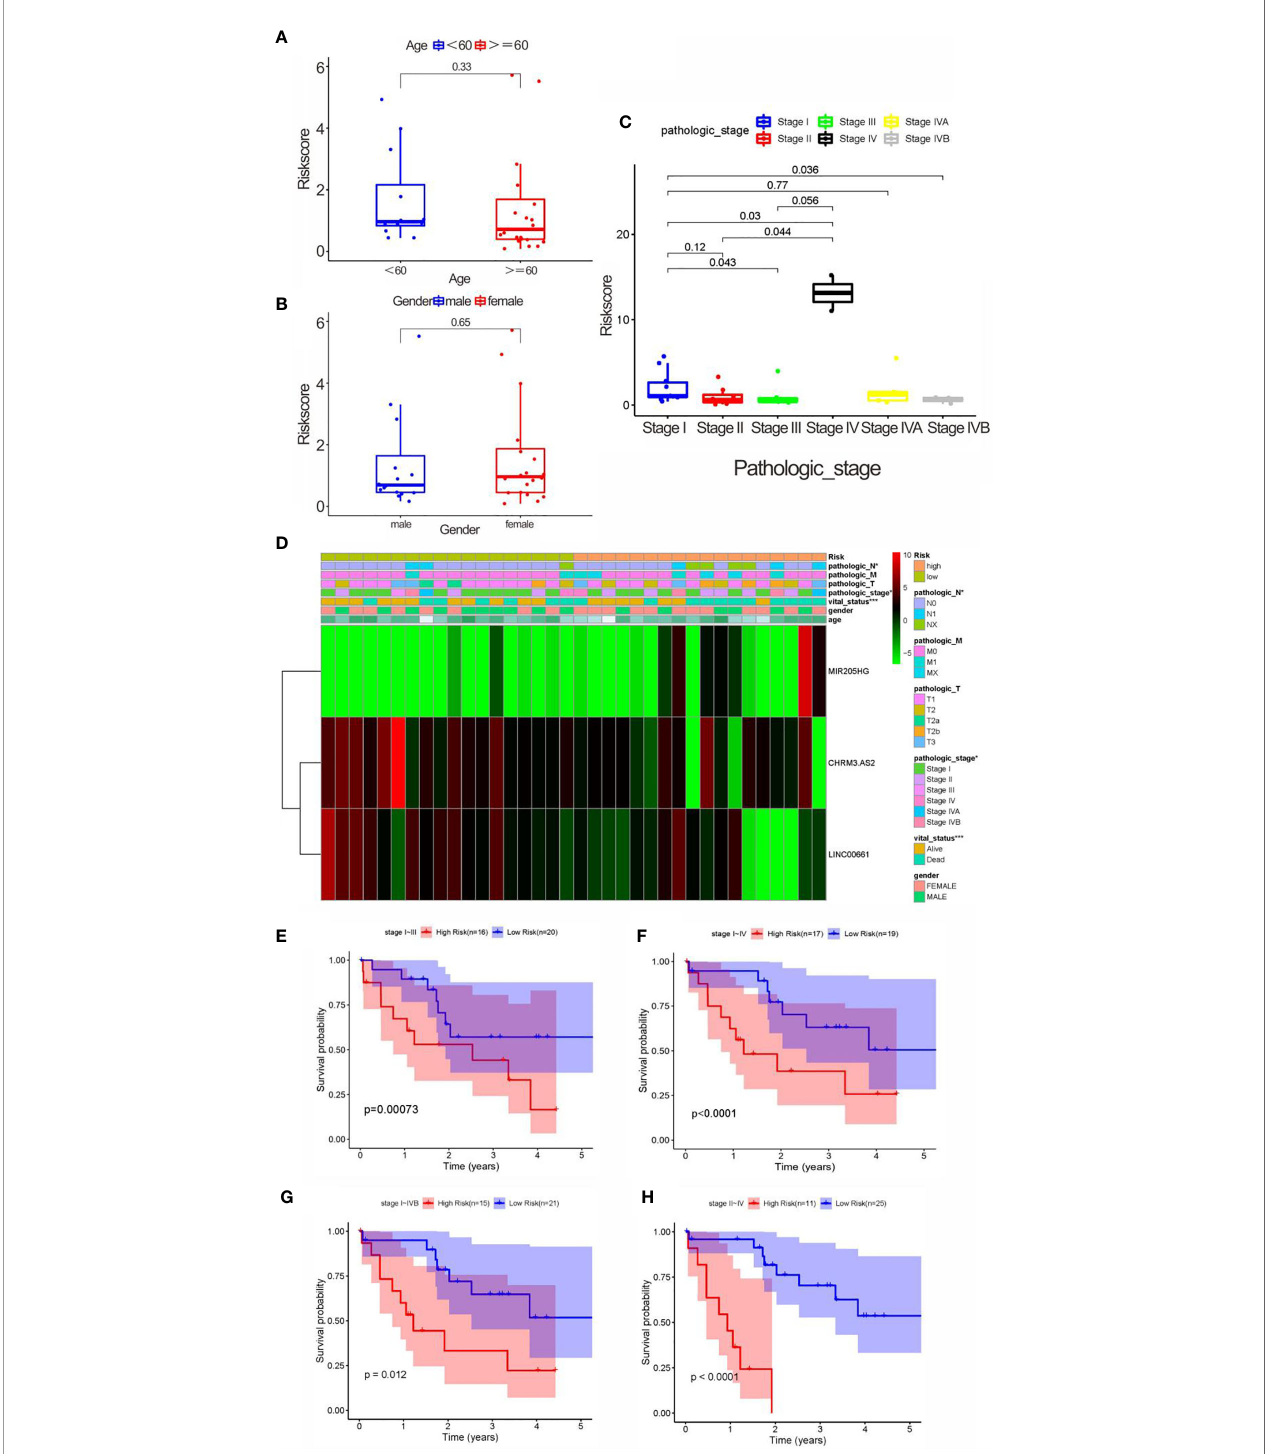
FIGURE 6 | Correlation analysis between clinical characteristics and risk scores. (A) Correlation between age and risk score, without signi fi cant difference (<60, and 60 years old). (B) Correlation between gender and risk score, without signi fi cant difference. (C) The correlation between pathological stage and risk score. (D) Heatmap of three key prognostic DEARlncRNA in the correlation of risk group and clinical traits. (E) K-M curve based on pathological stage (stages I and III). (F) K-M curve based on pathological stage (stages I and IV). (G) K-M curve based on pathological stage (stages I and IVB). (H) K-M curve based on pathological stage (stages II and